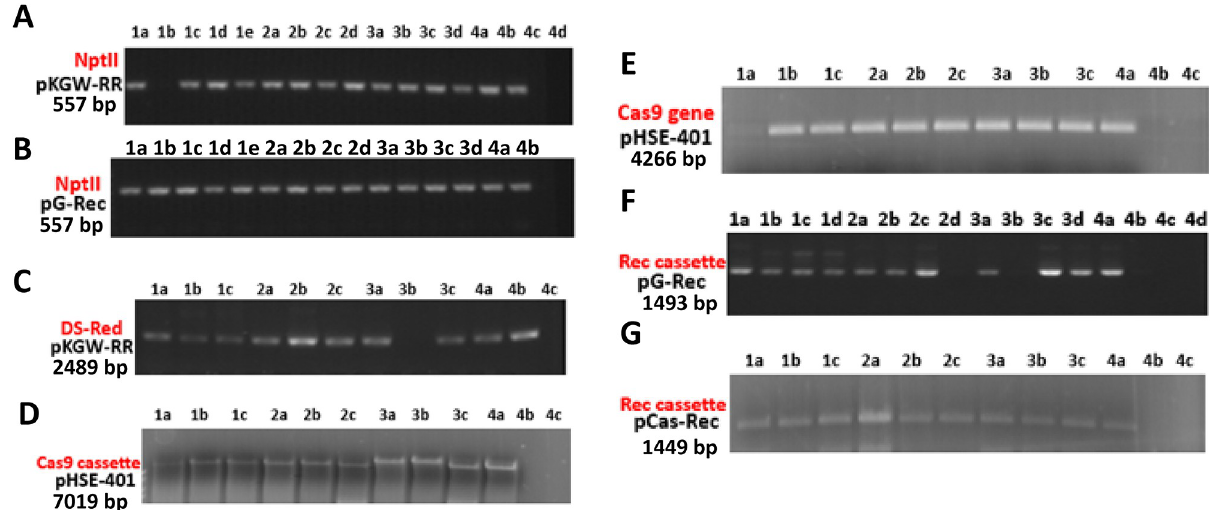
Fig 5. PCR amplification of pKGW-RR, pG-Rec, pHSE-401-Rep and pCas9-Rec. (5A) Kanamycin gene amplification (557 bp) in DNA samples transformed with DS-Red vector. (5B) Kanamycin gene amplification (557 bp) in DNA samples transformed with pG-Rec vector. (5C) Complete DS-Red cassette amplification (2489 bp) in DNA samples putatively transformed with pKGW-RR vector. (5D) Whole Cas9 cassette amplification (7019 bp) in plants transformed with pHSE-401-Rep. (5E) Cas9 gene amplification (4266 bp) in plants transformed with pHSE-401-Rep. (5F) Whole Rec cassette amplification in plants transformed with pG-Rec (1493 bp). (5G) Whole Rec cassette amplification (1449 bp) in plants transformed with pCas- Rec vector.